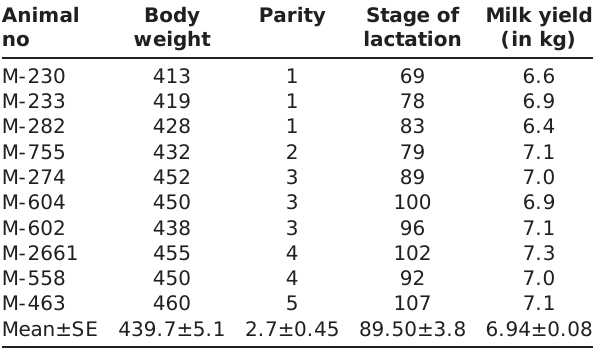
Table-1: Details of experimental buffaloes: Group I (control).